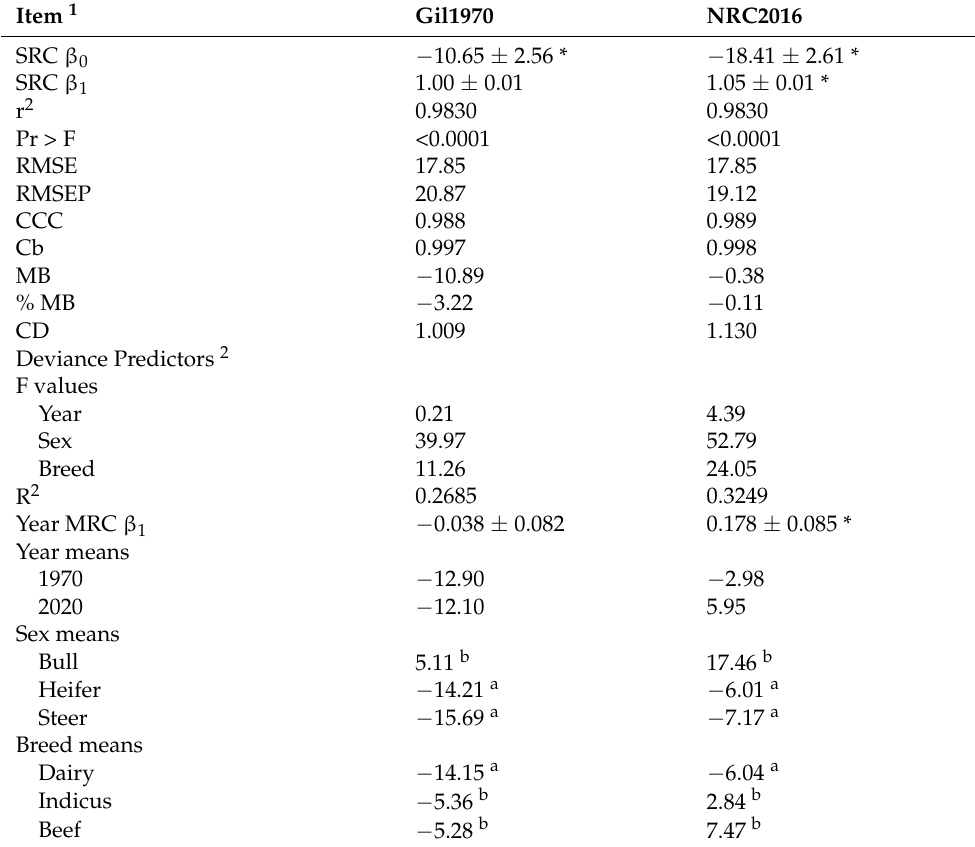
Table 2. Model evaluation of equations in predicting empty body weight computed from shrunk body weight, and predictive variables of the deviance between observed and predicted empty body weight using the Weight